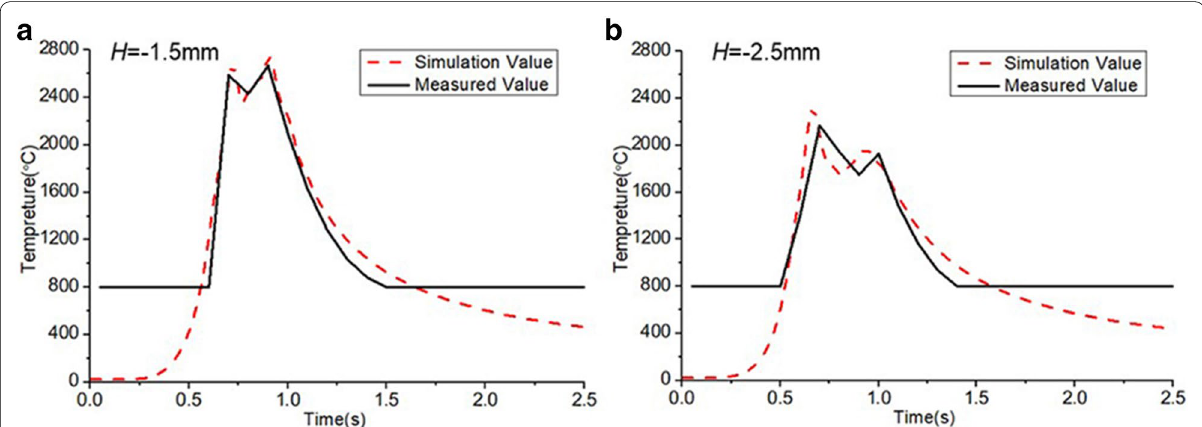
Figure 17 Comparison between predicted and measured temperatures: a H